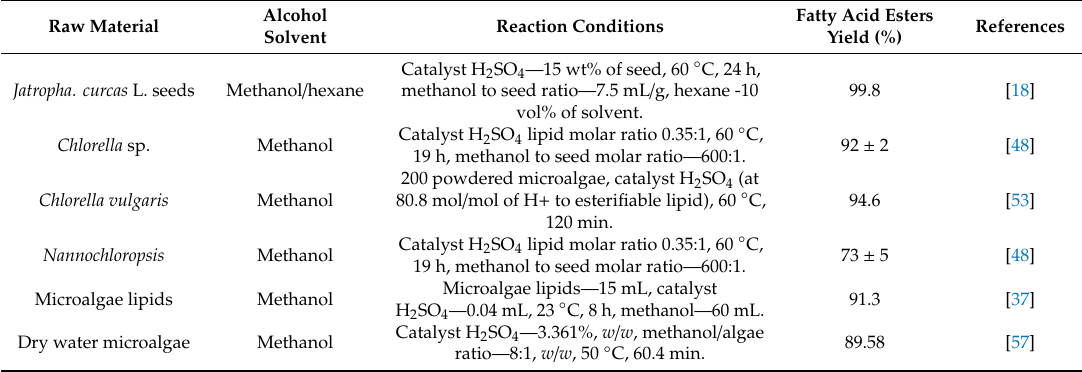
Table 1. Summary of studies on using chemical acid catalysts for in situ